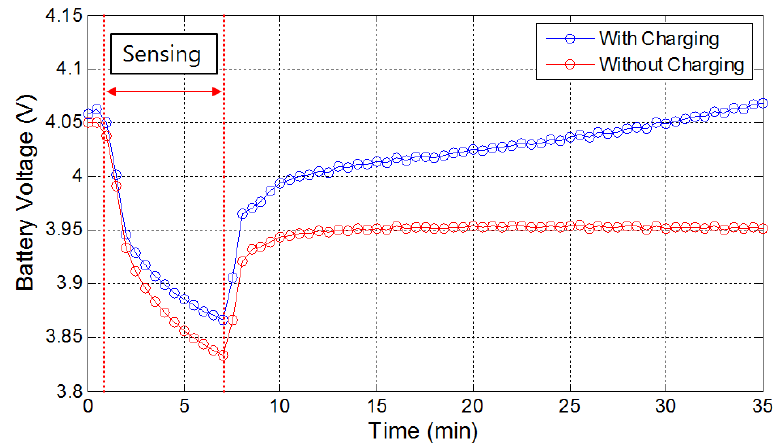
Figure 12. Battery levels according to the charging condition.